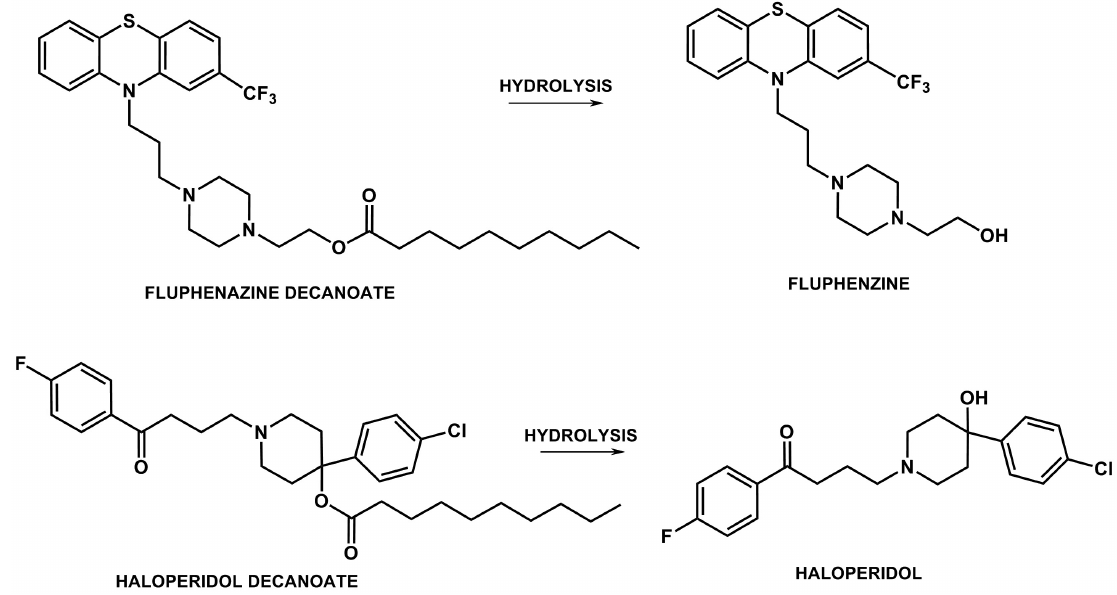
FIGURE 26 - Release of haloperidol and fluphenazine from their respective